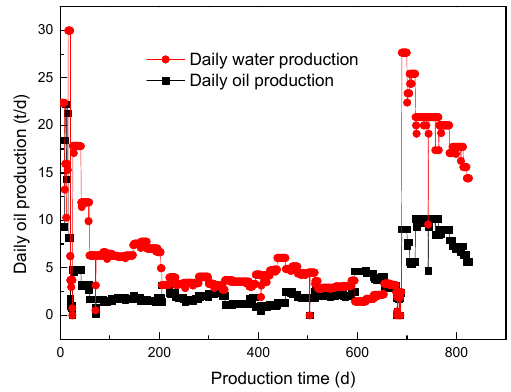
Figure 12. Target well production curve.